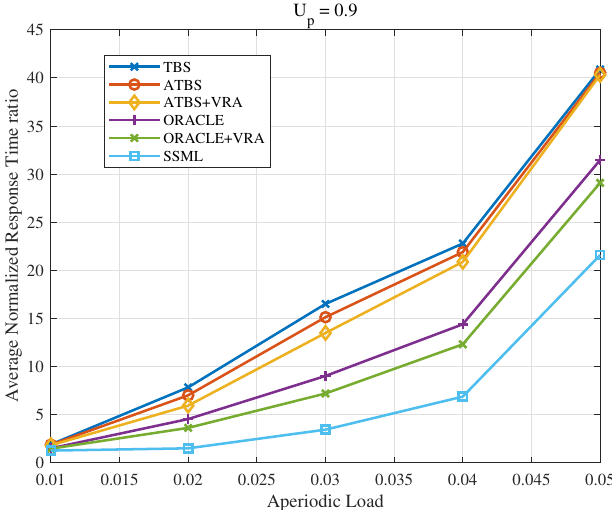
Figure 6. Comparison of average normalized response time ratio according to different aperiodic load at U p =